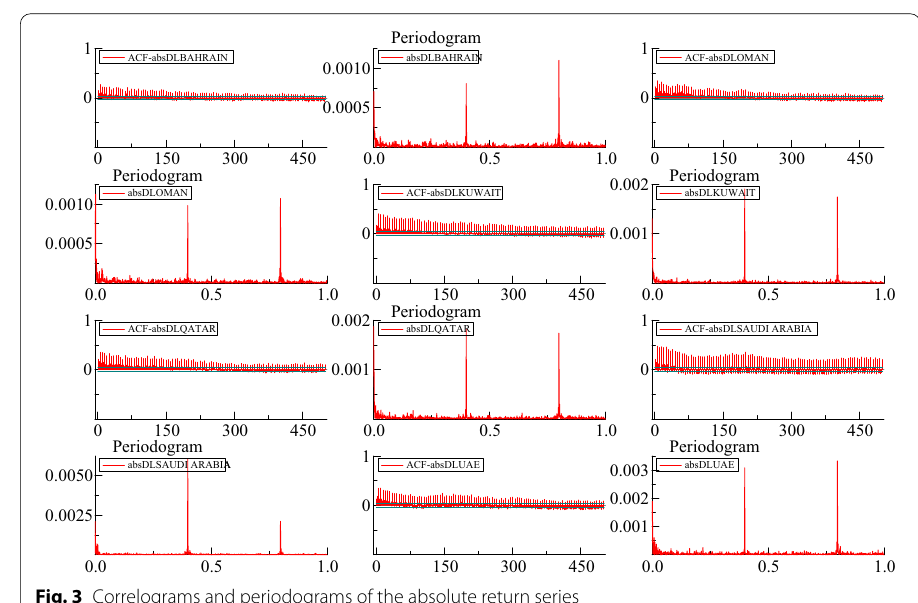
Fig. 3 Correlograms and periodograms of the absolute return